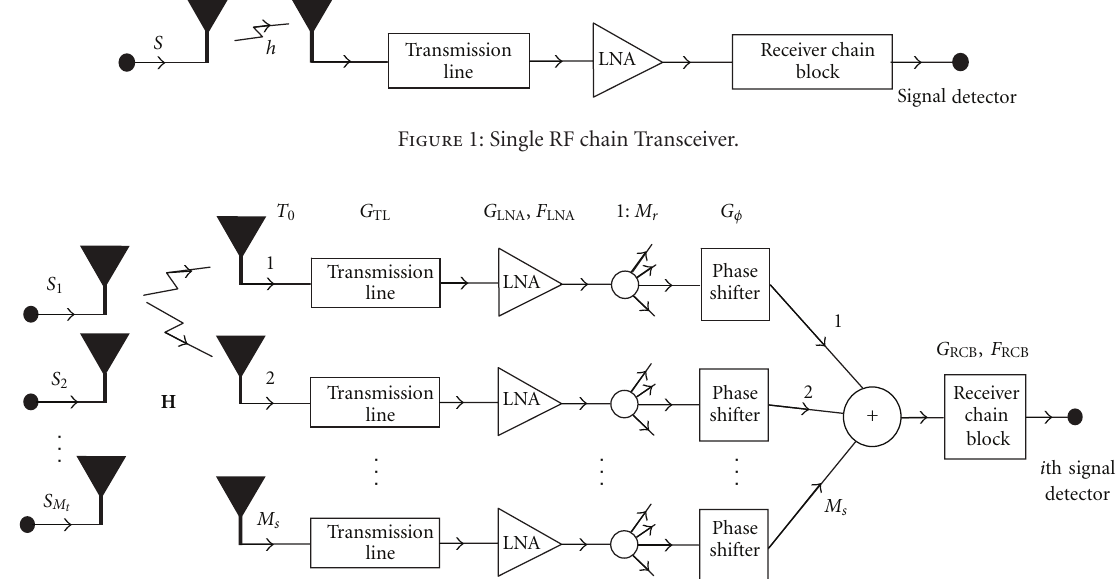
Figure 2: i th (out of M r ) receiver input for a SAS-MIMO with active phased array.